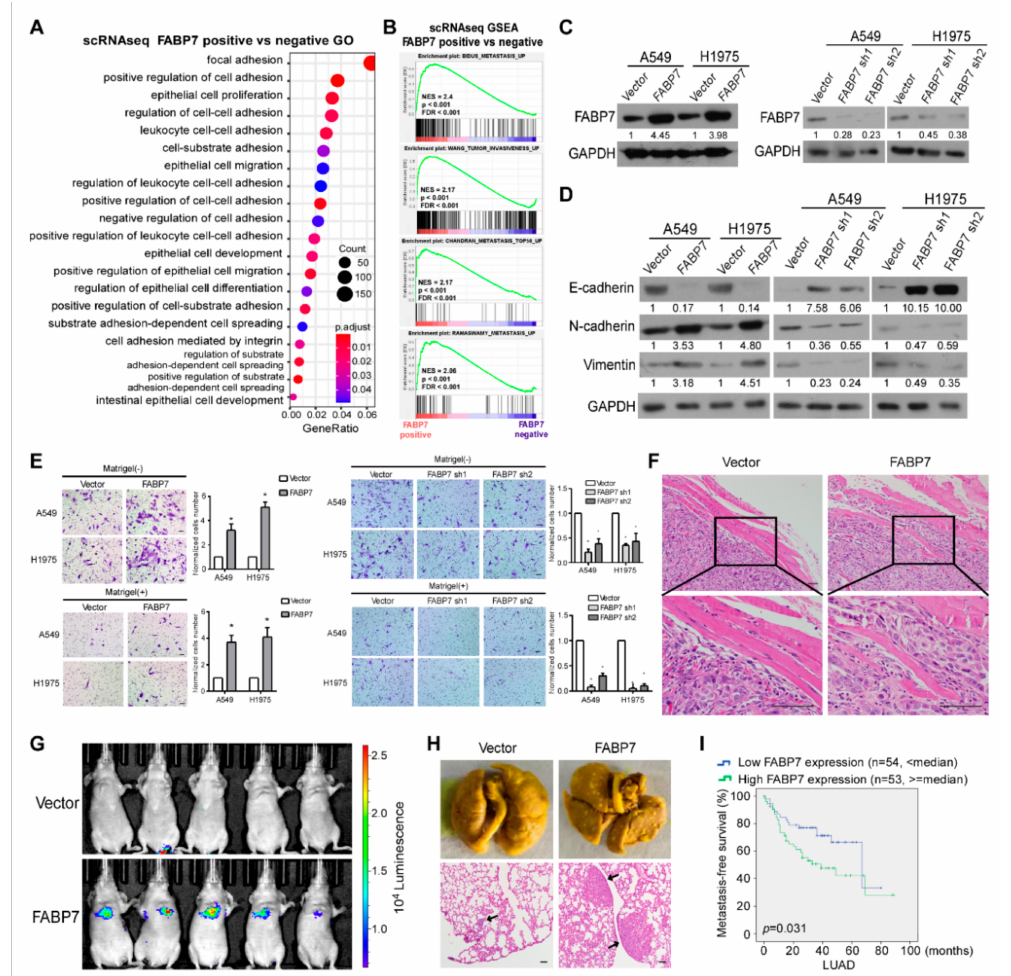
Figure 2. FABP7 contributes to NSCLC metastasis and indicates poor prognoses. ( A ) Metastasis- related biological functions enriched by Gene Ontology (GO) analysis. DEGs from scRNA-seq comparing FABP7-positive with FABP7-negative tumor cells were used for the analysis. ( B ) Gene Set Enrichment Analysis (GSEA) for DEGs between FABP7-positive and FABP7-negative malignant cells from scRNA-seq dataset. ( C ) Expression efficiencies of FABP7 stable over-expression (left) and knockdown (right) cell lines. Representative images from three independent experiments are shown. ( D ) Western blot analyses of EMT markers in NSCLC cells with stable over-expression or knockdown of FABP7. Representative images from three independent experiments are shown. ( E ) NSCLC cells were plated in chambers without or with matrigel respectively to perform transwell assays. Migratory (without matrigel) or invasive cells (with matrigel) were quantified in five random fields. Scale bar: 50 µ m. Error bars represent the means ± SD derived from three independent experiments. Statistical analyses were performed by two-sided Mann-Whitney test (*: p < 0.05). ( F ) Representative H&E staining images (insets: high-magnification images) of xenografts caused by vector or FABP7 A549 cells. n = 4, Scale bar: 50 µ m. ( G , H ) Indicated A549 cells (1 × 10 6 ) were injected via the tail vein. Representative bioluminescent images ( G ), picric acid staining and H&E staining ( H ) of